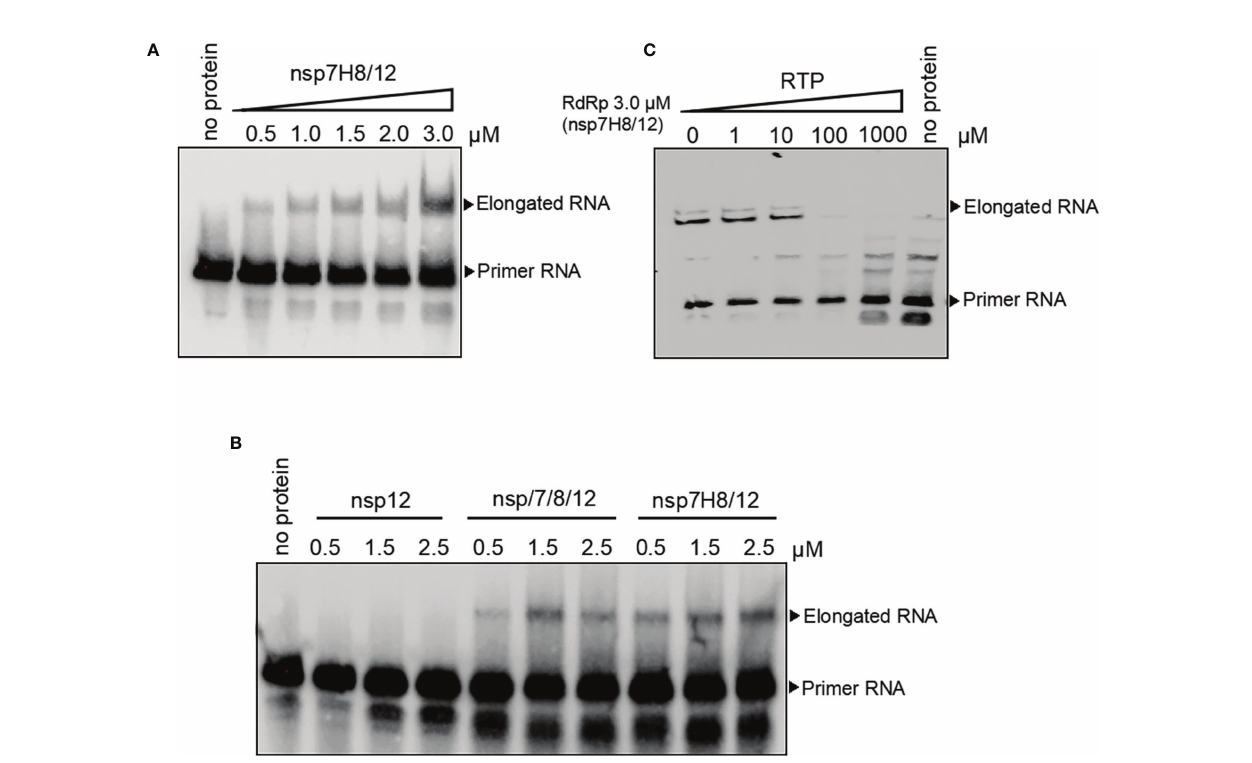
FIGURE 3 | The RdRp complex catalyzes in vitro RNA synthesis. (A) Gel-based primer-extension assay to test RdRp complex (nsp7H8/12) catalytic activity. (B) Gel-based RdRp complex activity assay of nsp12, nsp7/8/12, and nsp7H8/12. (C) RdRp complex activity was effectively inhibited by the addition of the active triphosphate form RTP. RTP: triphosphate remdesivir. Primer extension polymerase assays were performed using the long self-priming RNA as primer/template RNA and different combinations of nsp7, nsp8, nsp7H8, and nsp12 protein puri fi ed from Sf9 cells. nsp7/8/12: His 6 -nsp7, His 6 -nsp8, and nsp12; nsp7H8/12: nsp7-His 6 - nsp8 and